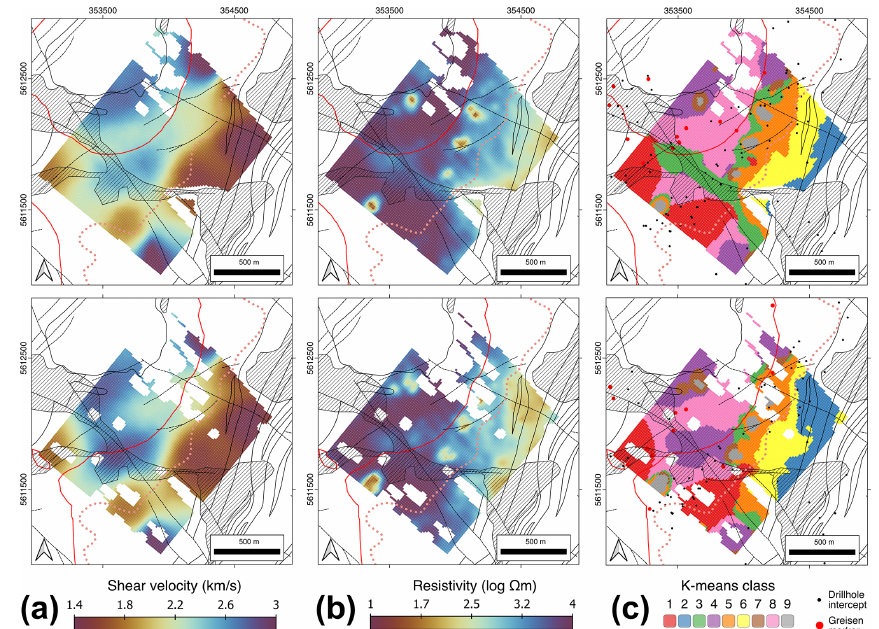
Figure 11. Horizontal sections through the combined shear velocity–resistivity block model at elevations of 560m (top) and 510m (bottom), respectively, showing (a) shear velocity, (b) resistivity, and (c) classification. The overlay shows the geological boundaries from the geological map (Fig. 1). The red line represents the granite–two-mica schist interface at the corresponding depth as extracted from the 3D geological model (Kirsch and Steffen,